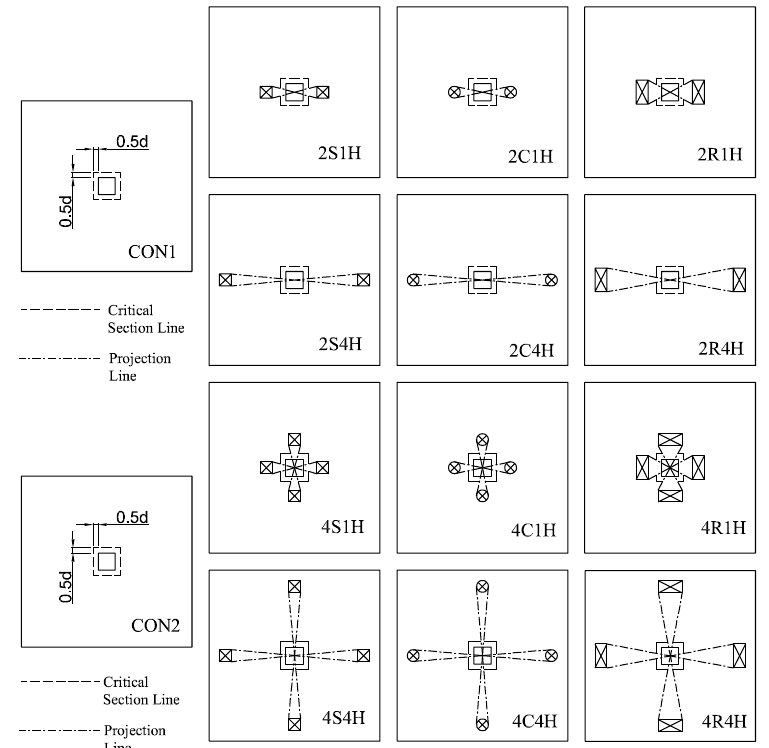
Buildings 2021 , 11 , x FOR PEER REVIEW 20 of 24 Figure 17. Definition of critical perimeter as per ACI 318-19. Figure 17. Definition of critical perimeter as per ACI 318-19.